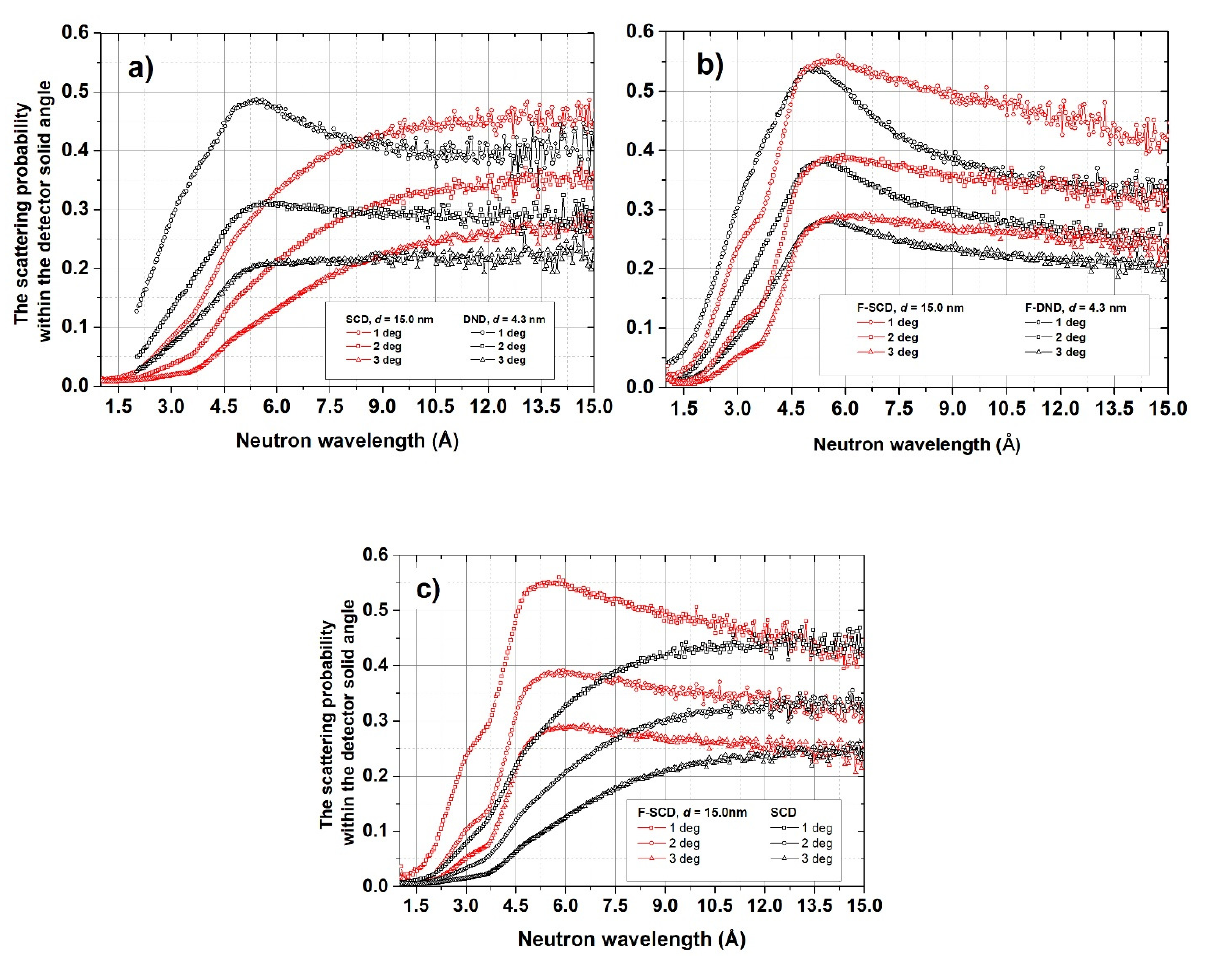
Figure 8. Neutron scattering probability as a function of neutron wavelength (horizontal axis) within the D17 detector acceptance. ( a ) DND and SCD samples; ( b ) F-DND and F-SCD samples; ( c ) SCD and F-SCD samples. Incident angles 1°, 2° and 3°. The angular distribution of quasi-specularly reflected neutrons is shown in Figure 9.